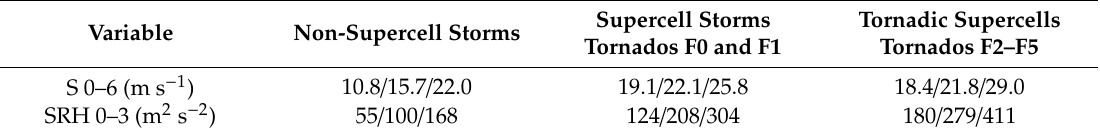
Table 2. Reference values for S 0–6 and storm-relative helicity (SRH) 0–3 from [31]. Values in each cell represent median / 75th percentile / 90th percentile. F represents the tornado category according to the Fujita